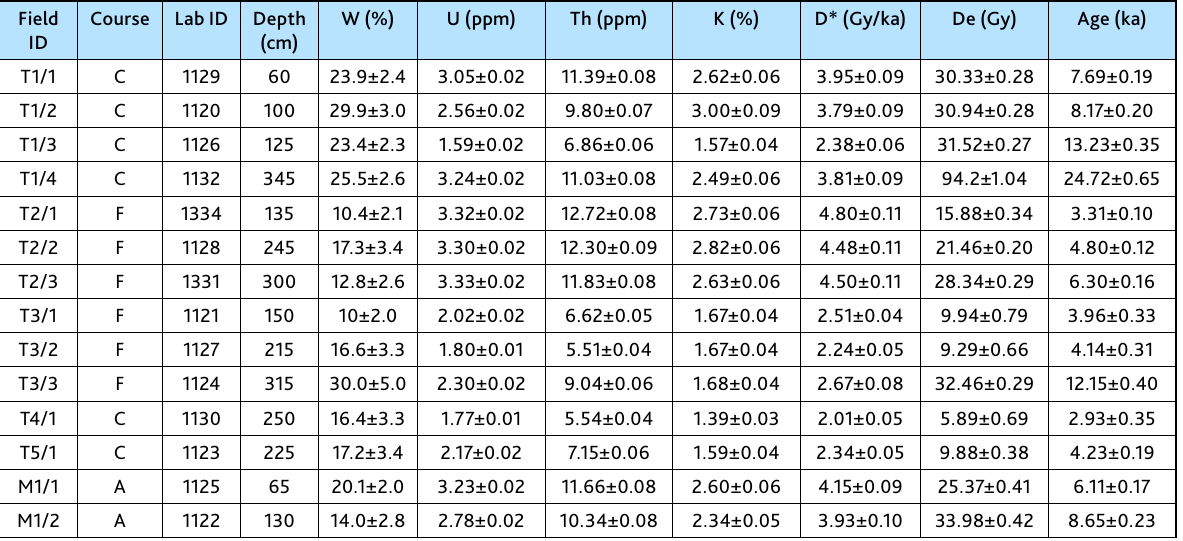
Table 2. Results of the OSL dating. W: water content, D*: environmental dose rate, De: equivalent dose.